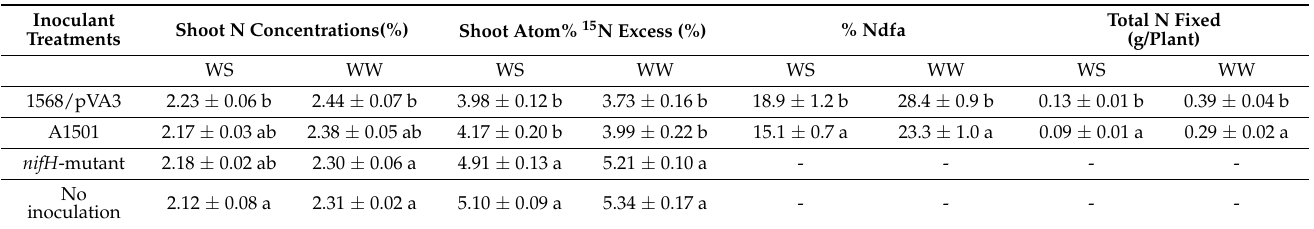
Figure 2. Relative percentage of growth improvement for the weight of shoots and roots ( a ) and the length of shoots and roots ( b ) induced by P. stutzeri inoculation in maize plants. Control, plant without inoculation; A1501, plant inoculated with wild-type; 1568/pVA3, ammonium-excreting strain; 1502, nifH -mutant. WS—water stress condition; WW—well-watered condition. The values are mean ± standard deviation (n = 16). The statistical analysis was carried out with ANOVA followed by the Duncan test. * p -value ≤ 0.05 or ** p -value ≤ 0.01. Table 3. Effects of the inoculation with P. stutzeri A1501 wild-type and mutant strains on nitrogen concentrations and atom % 15 N excess of maize stems. The values are mean ± standard deviations (n = 20). Different letters (a–b) indicate a significant difference ( p < 0.05) according to ANOVA analysis. WS—water stress condition; WW—well-watered